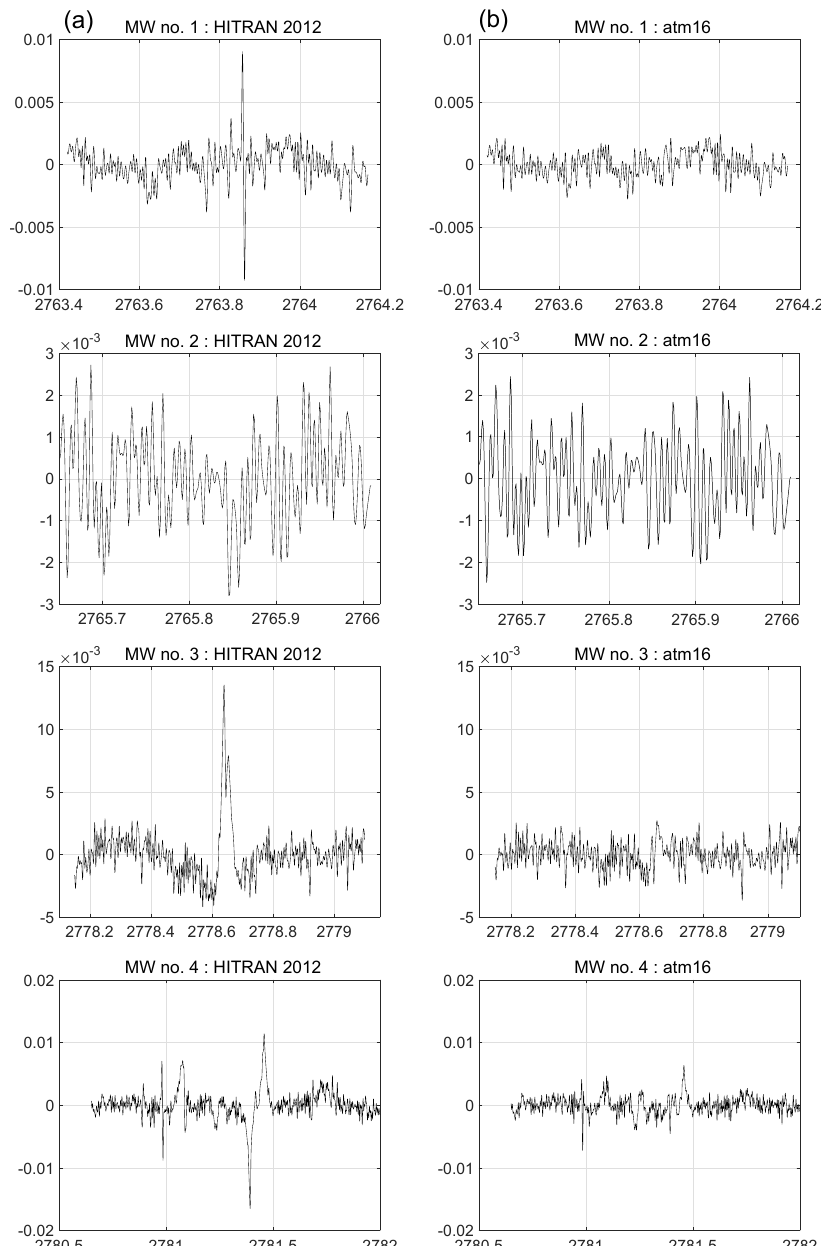
Figure 3. Residuals (calculated – observed spectrum) in each of the four MWs for the retrieval of a spectrum recorded on 12 February 2014 at Maïdo and corresponding to a retrieved HCHO total column of 2 . 48 × 10 15 moleccm − 2 . The x axis represents the wave number in cm − 1 . Panels (a) are obtained when the HITRAN 2012 spectroscopy is used, and panels (b) show the improvement made by using the atm16 line